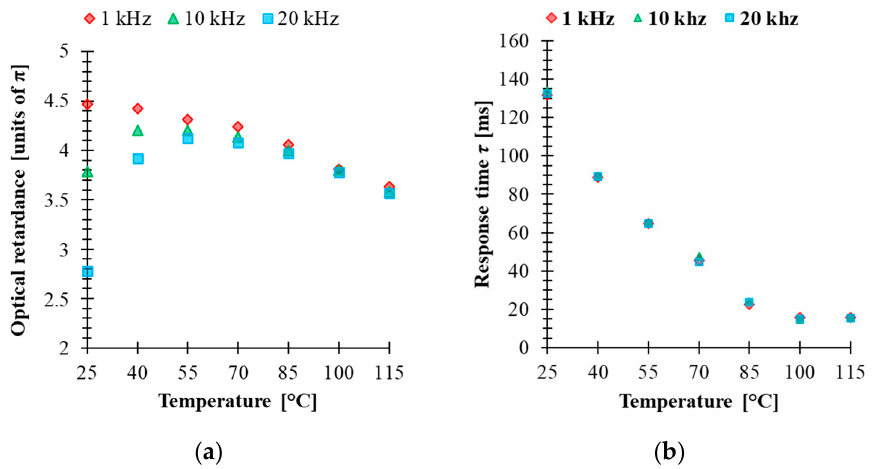
Figure 3. Voltage-dependent optical retardance of 5005 mixture at different temperatures ( λ = 633 nm, cell gap 5 μ m) for different frequencies of applied square AC signal: ( a ) 1 kHz, ( b ) 10 kHz, ( c ) 20 kHz.